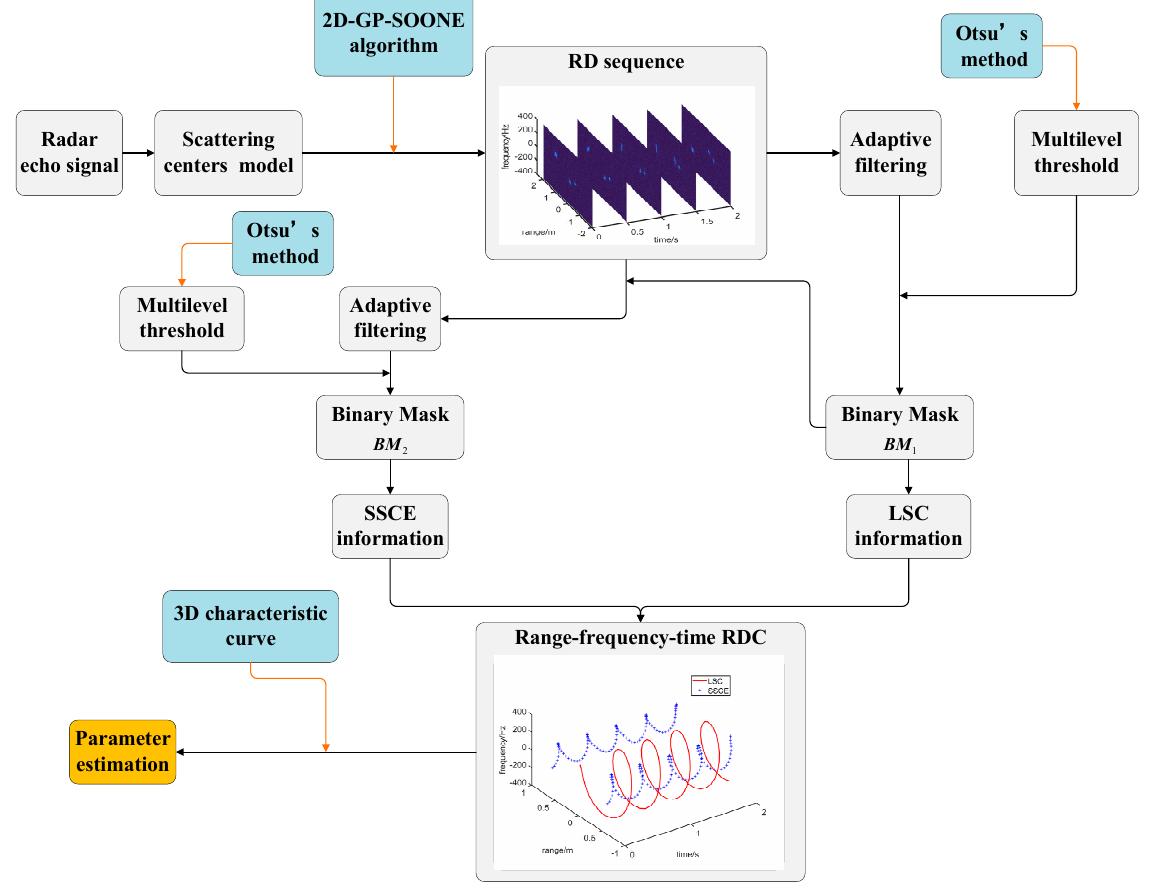
Figure 3. Schematic diagram of the proposed method.